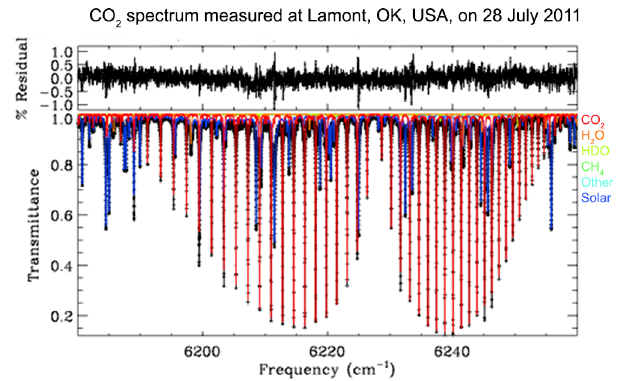
Figure 3. A typical spectrum in the 6220cm − 1 band. The calcu- lated spectrum, produced by GFIT in profile scaling mode, is su- perimposed, with the individual gas contributions shown in color. CO 2 , solar lines, and H 2 O dominate the visible features. The resid- uals (also typical) are shown in the upper panel. This spectrum is one of the atmospheric measurements used in Sect. 4.2 and subse-